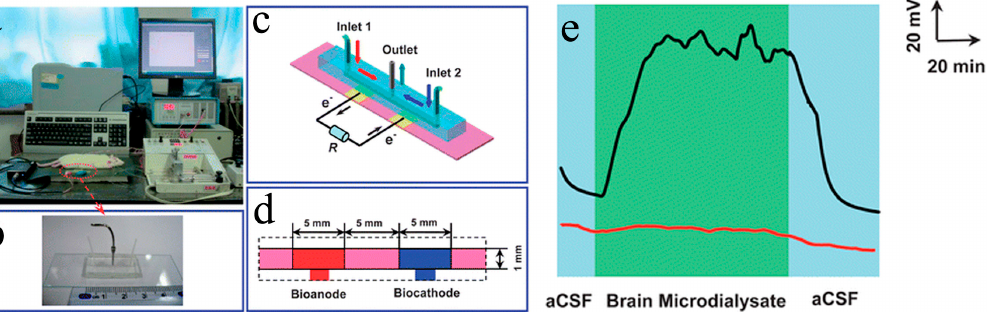
Figure 9. ( a ) Schematic diagram of the µ -EBFC-SPB for the continuous monitoring of the glucose in rat brain, the digital photograph ( b ) and schematic diagram ( c , d ) of this µ -EBFC-SPB. ( e ) The voltage-time response of the sensor recorded by continuously analyzing the cerebral neurodialysis fluid [63]. Copyright 2013 Royal Society of Chemisty.